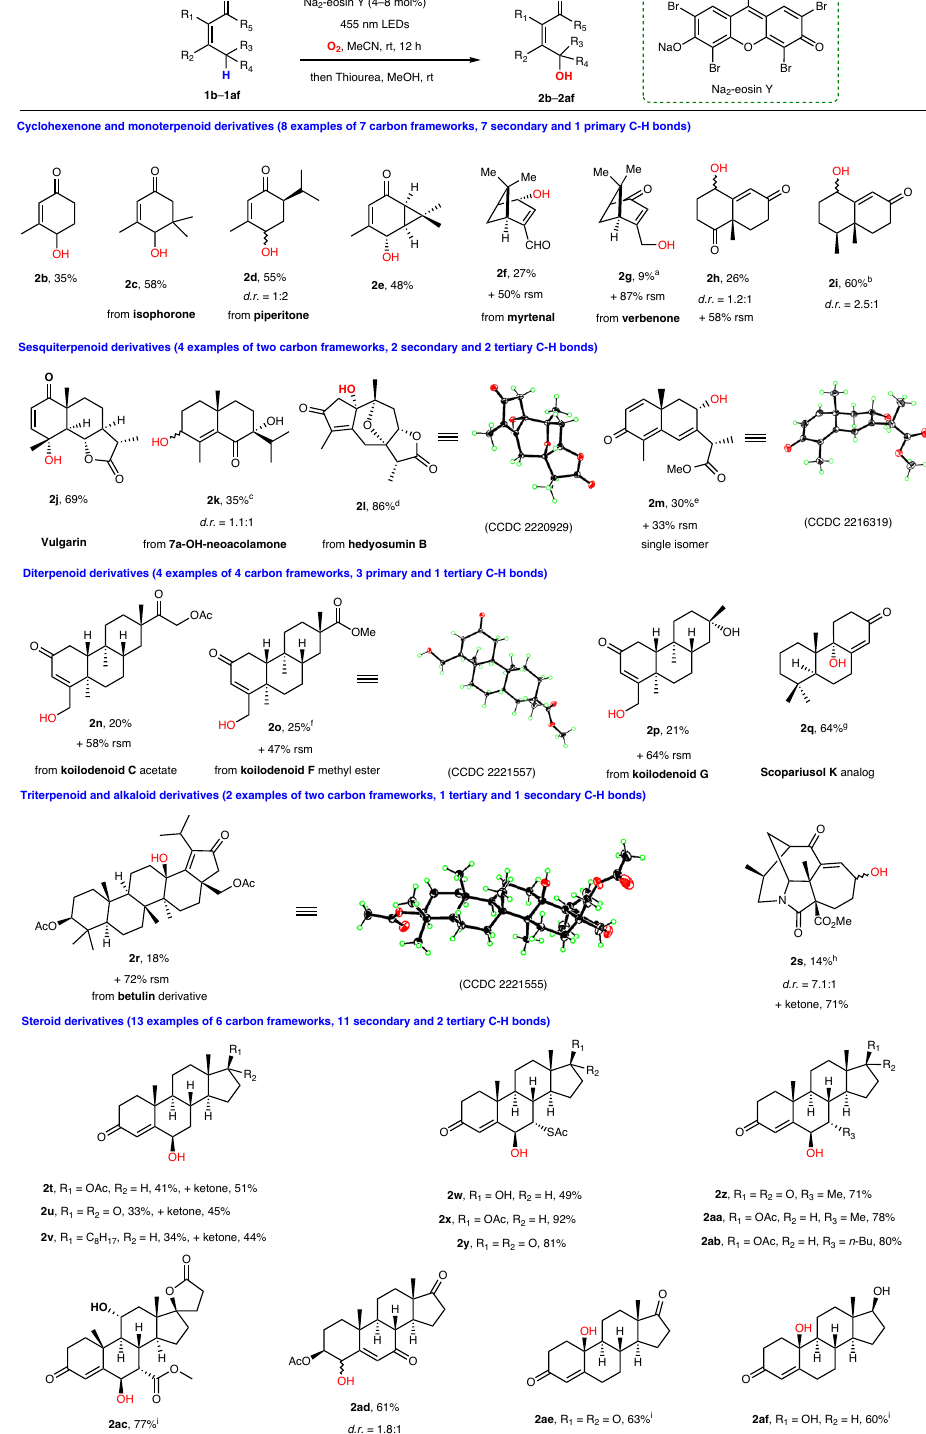
Fig.2|Scopeoftheprimary,secondary,andtertiaryC(sp 3 ) – Hhydroxylationof varied structural types of enones enabled by visible-light-induced hydrogen- atom transfer. Reaction conditions: enone (0.20mmol), Na 2 -eosin Y (7mol%), O 2 balloon, and MeCN (10mL) at r.t. under the irradiation of 50W 455nm LEDs for 12h; then thiourea (0.24mmol, 1.2 equiv.) and MeOH (10mL) were added and stirred for 4h unless otherwise noted; Isolated yields are reported. a